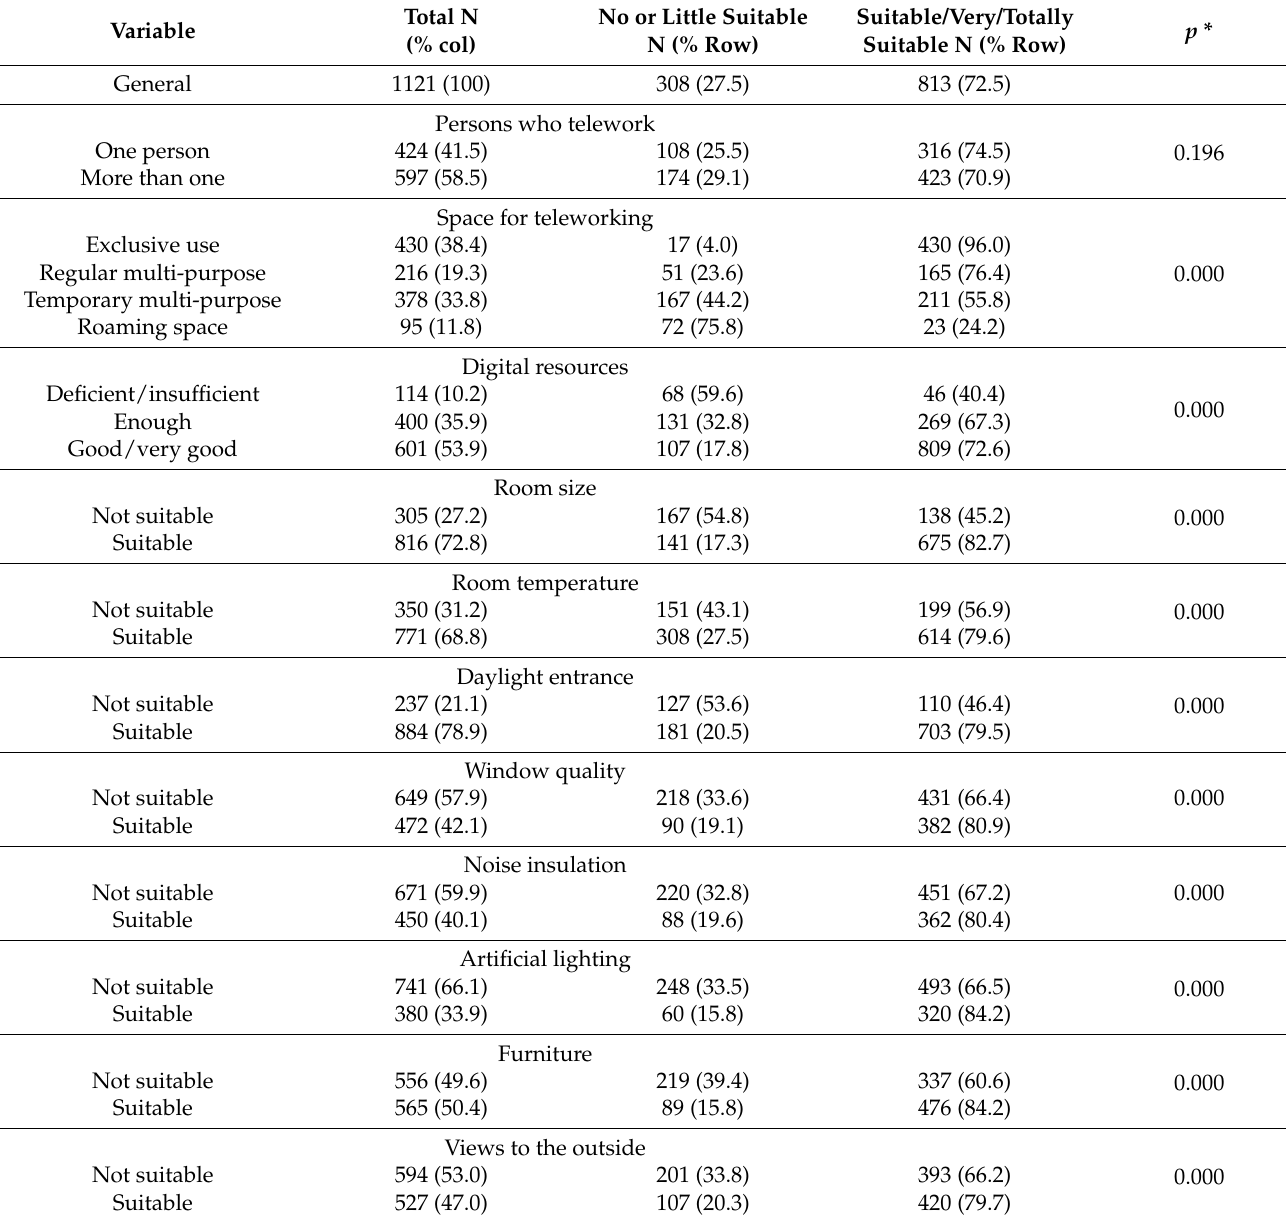
Table 3. Aspects of the telework space according to the perception of its